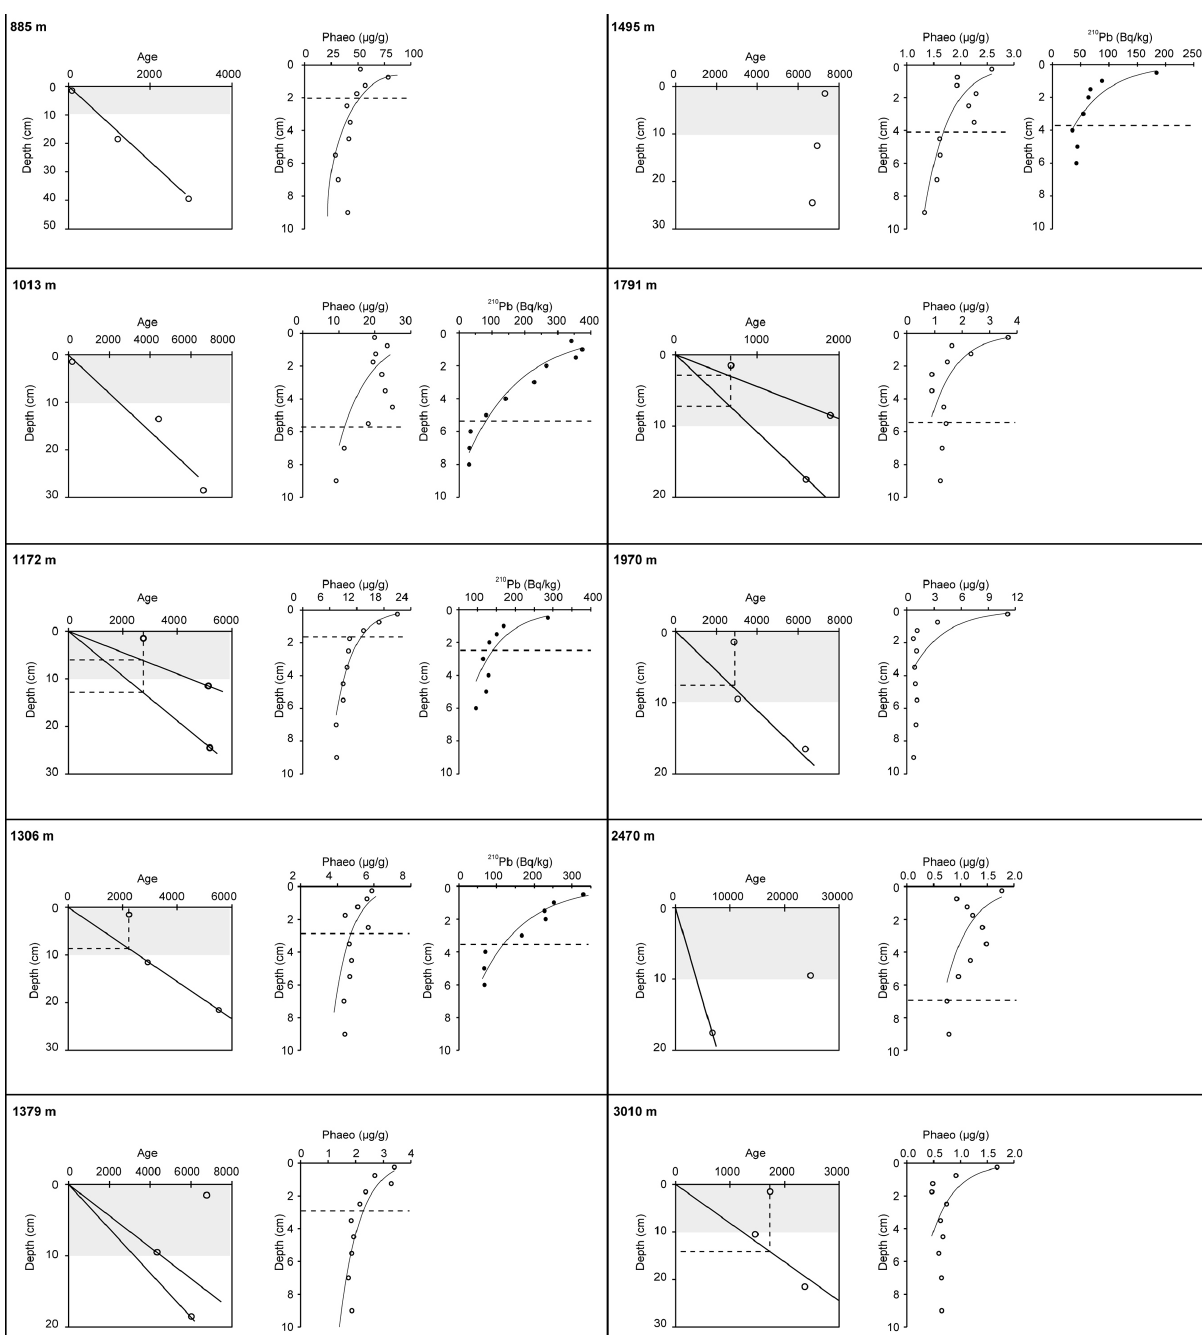
Fig. 4. Sediment mixing or bioturbation indicators used in this study. Stations from 885m depth down to 1379m water depth are located in the OMZ and stations from 1495m depth to 3010m depth are located outside the OMZ. Three mixing indicators used: 14 C data to give age of sediment in absolute years, and down core phaeopigment and 210 Pb data. Due to various half-lives of the mixing indicators, long- term and short-term mixing can be examined independently, see main body of text for more detail. Light grey shading in the 14 C age plots indicates the top 10cm of sediment, which is also shown in phaeopigment and 210 Pb profiles. Horizontal, dashed lines indicate the inferred mixing/bioturbation